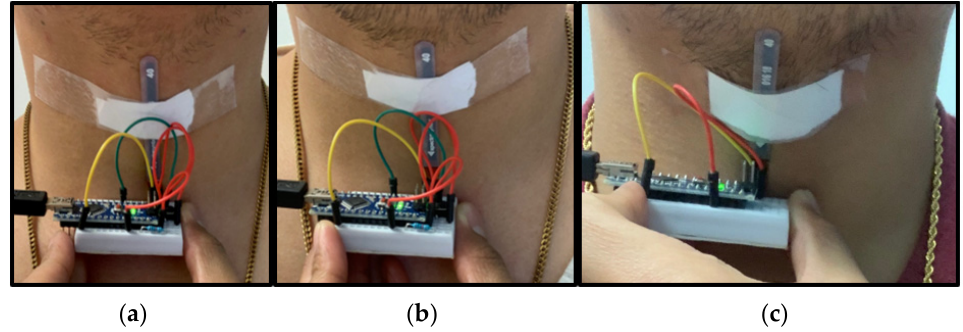
Figure 2. ( a ) Low, ( b ) center, and ( c ) high placement of the short flex sensor along the center line of the neck.